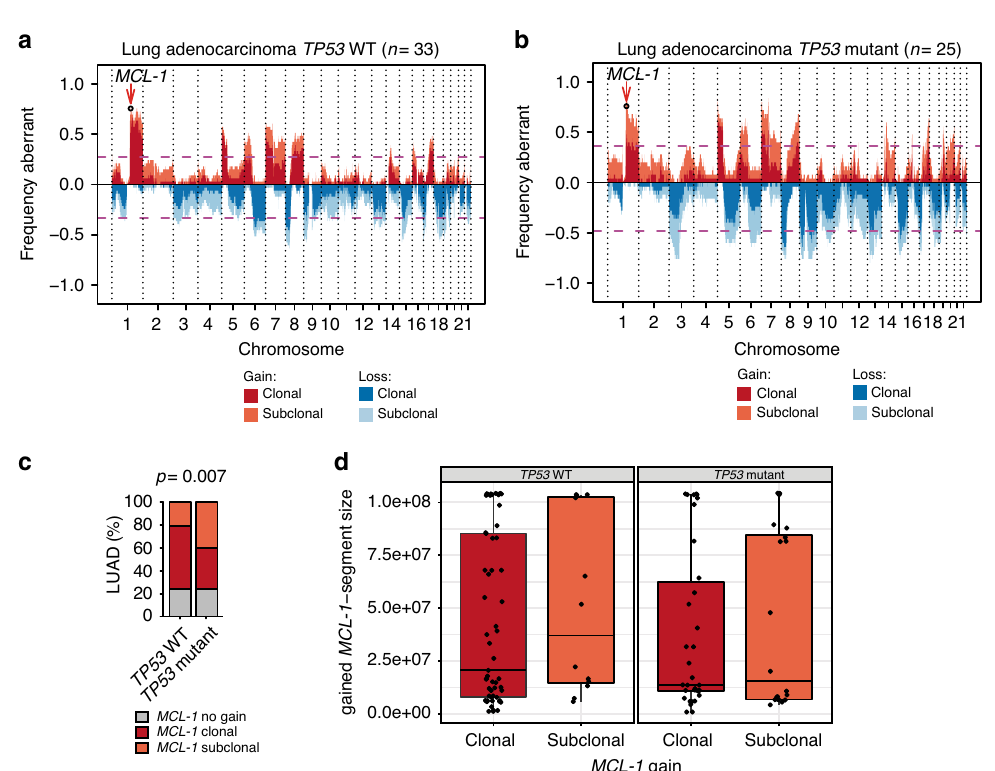
Fig. 2 TP53 mutation associates with subclonal MCL-1 gains. a , b CNA expressed as frequency in TRACERx LUAD grouped for TP53 wild-type (WT) ( a ) and mutant ( b ). Shading indicates clonal status. n = number of patients. c Frequency distribution of MCL-1 gain in TP53 wild-type or clonal mutant TRACERx LUAD patients. Data were analysed by Pearson ’ s chi-squared test with continuity correction ( p = 0.007, chi-square(2) = 9.885). d Comparison of MCL-1 - segment sizes between clonal and subclonal MCL-1 gains for TP53 mutant and WT samples. Two-sided Wilcoxon testing showed no signi fi cant differences. TP53 mut n = 54 (34 clonal and 20 subclonal gains, p = 0.89, W = 348) TP53 WT n = 69 (57 clonal and 12 subclonal gains, p = 0.53, W = 302). n = number of samples. The data are presented as box plot, where the centre line represents the median value, the limits represent the 25th and 75th percentile, the whiskers represent the minimum and maximum value of the distribution, and the points represent the individual experimental primary LUAD patient samples and matched healthy lung tissue. Notably, MCL-1 expression intensity was signi fi cantly higher in LUAD tissue than in healthy adjacent tissue (Fig. 3g, h). These results are consistent with previous reports on MCL-1 protein abundance in lung cancer 14,19,20 . Taken together, these data indicate that MCL-1 clonal and